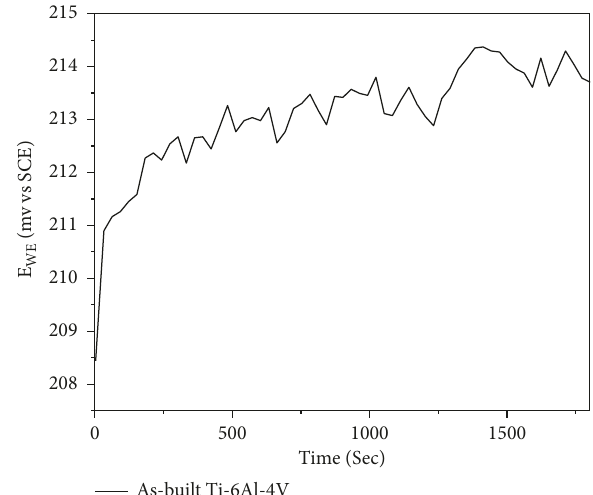
Figure 1: Open circuit potential of as-built Ti-6Al-4V in 0.5MH2SO4.